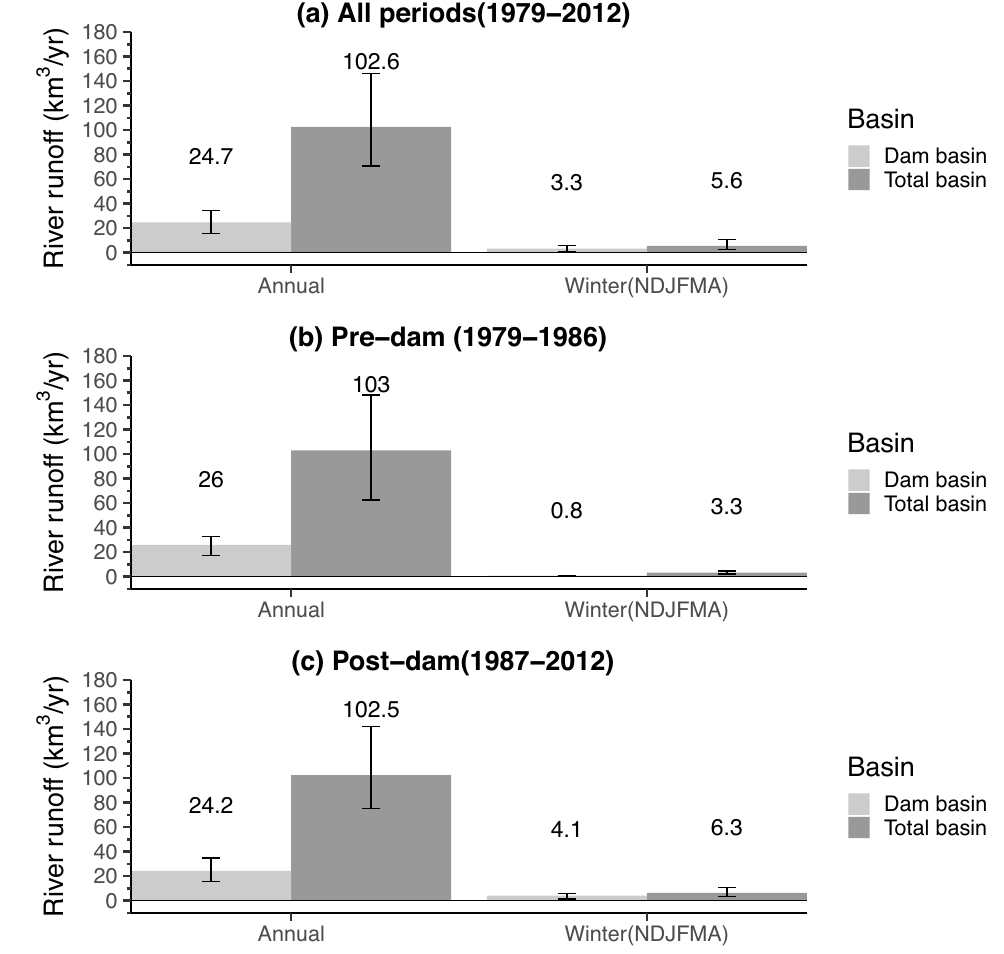
Figure 13. Comparison of runoff from the total and Dam basin annually and in winter (NDJFMA) season: ( a ) Entire period (1979–2012); ( b ) Pre-dam (1979–1986), and ( c ) Post-dam (1987–2012). The number above each bar denotes a mean value for that bar, while the accompanying vertical line denotes 95% confidence intervals